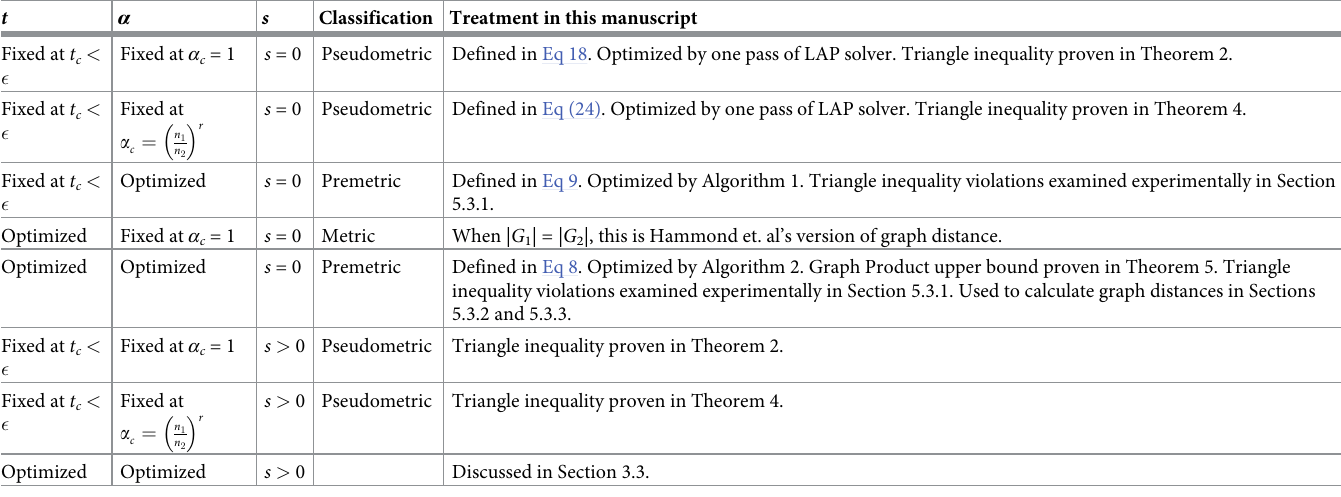
Table 1. Summary of this paper’s investigation of different forms of our graph dissimilarity measure. In this work, we systematically explore properties of this measure given sparsity parameter s = 0, and various regimes of t (fixed at some early time, or maximized over all t ) and α (fixed at α = 1, fixed at a constant power r of the ratio of graph sizes, or minimized over all α . We leave exploration of nonzero values of the sparsity parameter to future work. Variants not explicitly called out are not considered. In the case where α and t are both optimized and s > 0, it is unclear which of the metric conditions GDD satisfies, hence the corresponding classification is left blank. s Classification Treatment in this